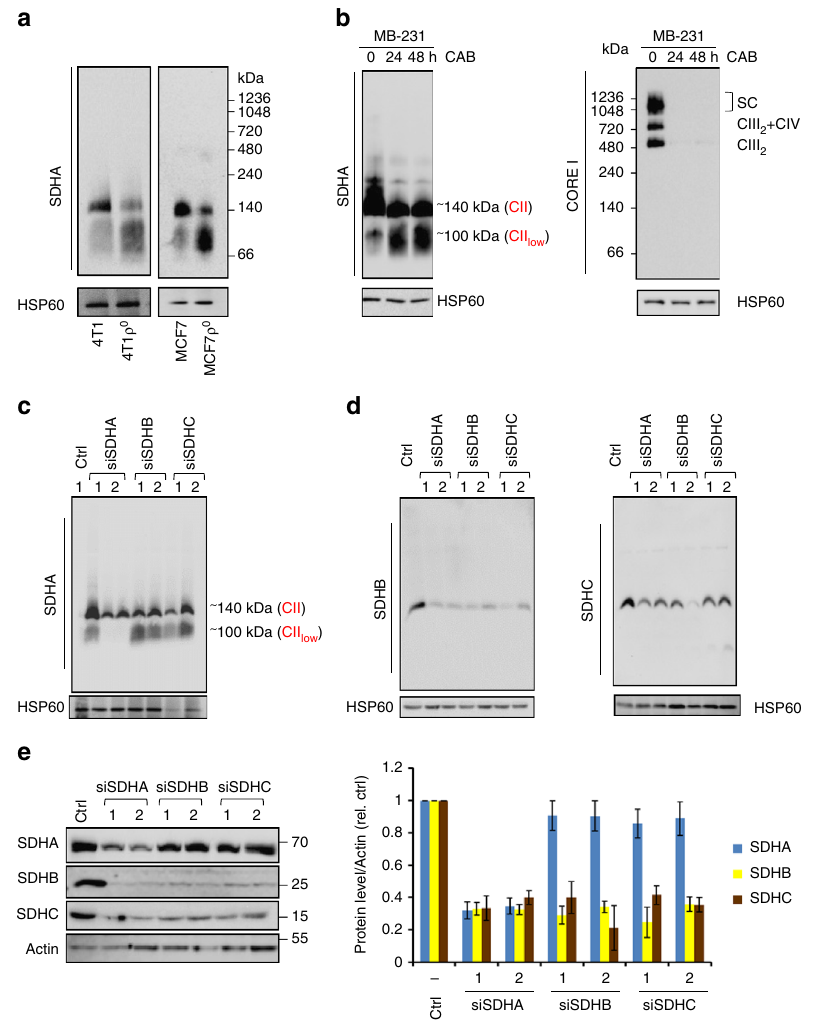
Fig. 1 mtDNA dysfunction affects CII assembly. a NBGE analyses of CII assembly from digitonin-solubilized mitochondria isolated from 4T1 and MCF7 cells and their ρ 0 counterparts. b NBGE showing formation of CII low and depletion of CIII assembly upon suppression of expression of mtDNA-encoded genes with CAB at indicated time points. c , d NBGE of CII using mitochondria isolated from 4T1 cells transfected with siRNA against SDHA, SDHB, or SDHC. e WB after SDS-PAGE of steady-state levels of CII subunits in 4T1 cells treated with siRNAs as shown (left panel). Right panel shows quanti fi cation of WB in the left panel related to actin. The numbers ‘ 1 ’ and ‘ 2 ’ in c – e refer to two different siRNAs. Data shown are mean values± SD; images are representative